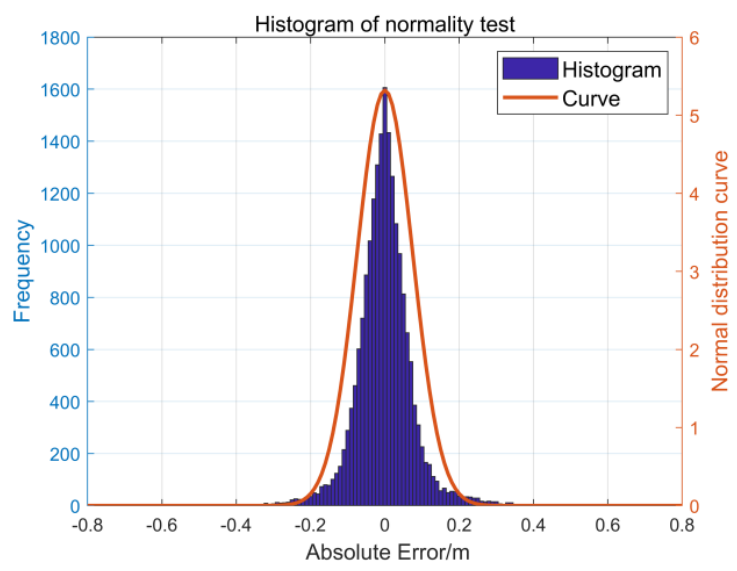
Figure 15. Histogram of normality test.